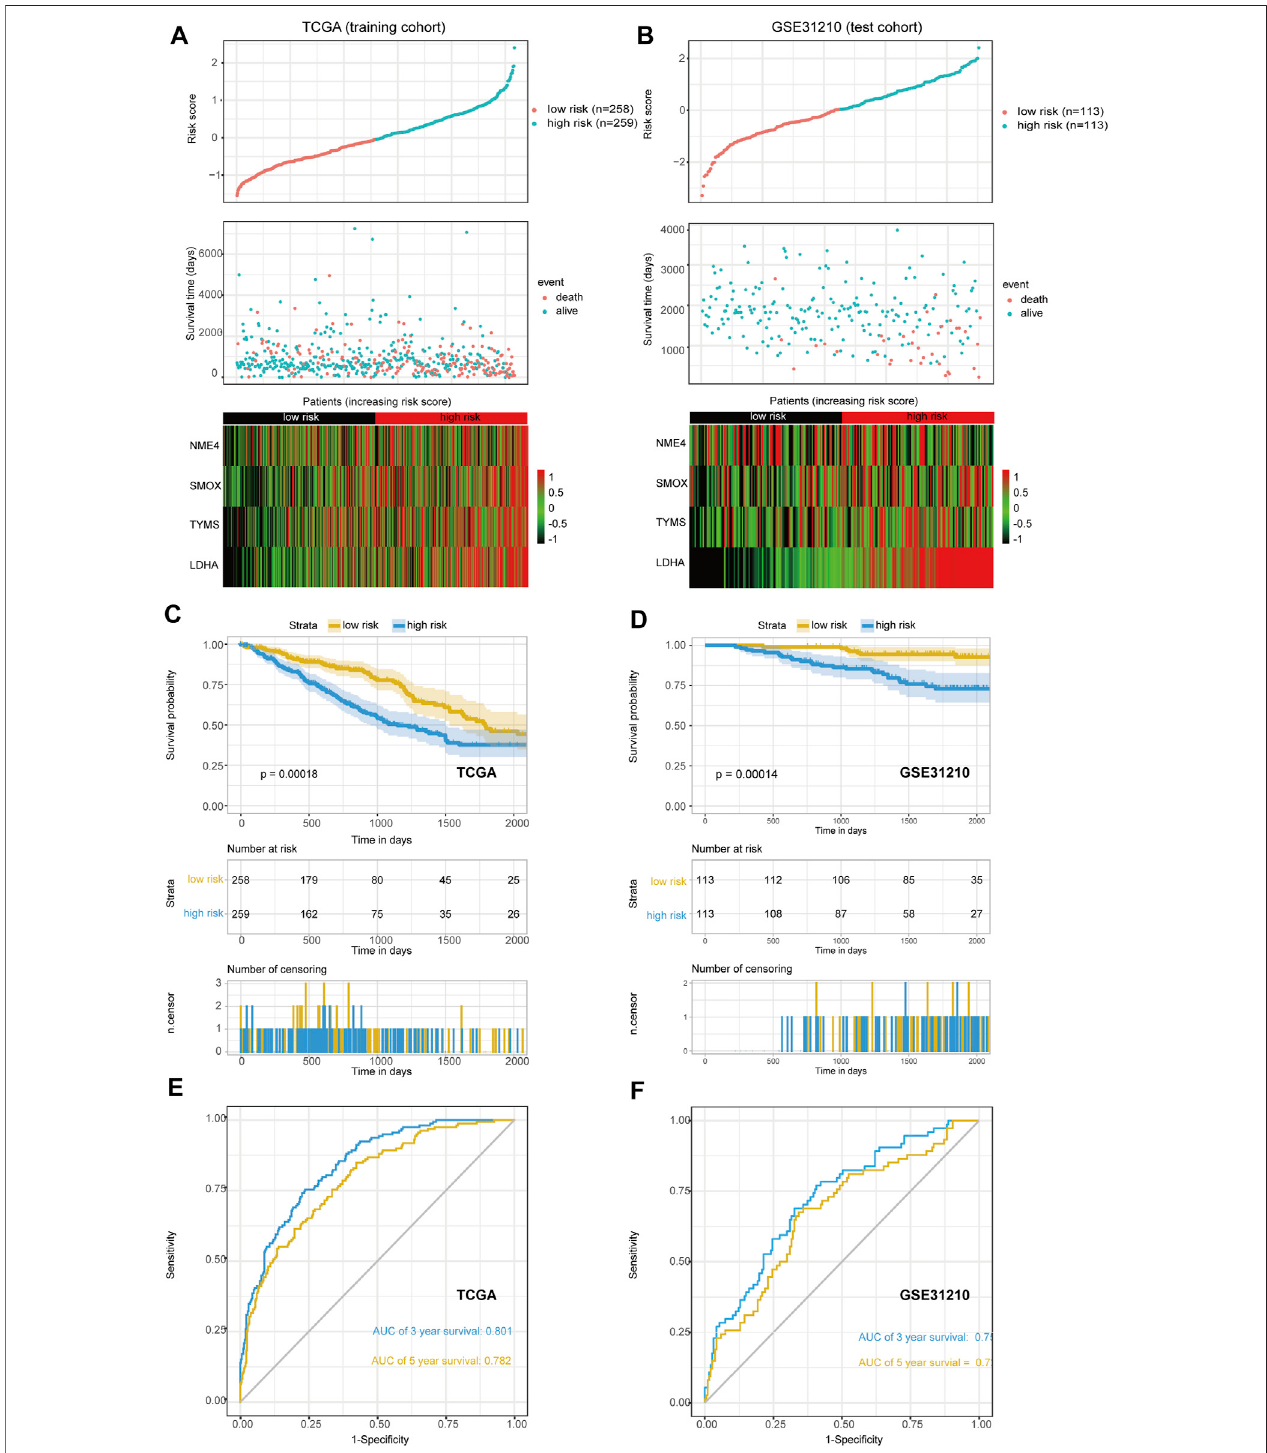
FIGURE3 | The scatter plotof riskscore and heat map offour prognostic genes. (A,B) Thetraining set (A) and the fi rst validation set (B) are shown. (C,D) Kaplan- Meiercurvesofoverallsurvival(OS)forpatientswithLUADbasedontheriskscore.Thetrainingset (C) andthe fi rstvalidationset (D) areshown (E,F) The3-,and5-years ROC of the risk model. The training set (E) and the fi rst validation set (F) are shown.